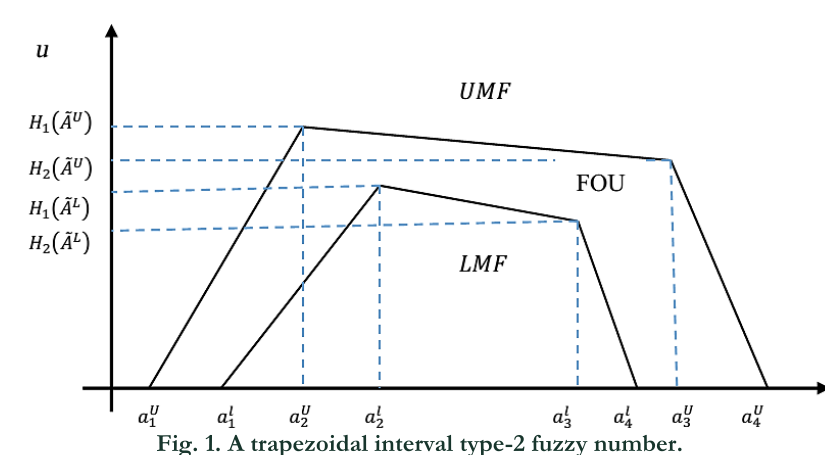
Fig. 1. A trapezoidal interval type-2 fuzzy